Question: Summarize what this figure shows in one sentence.
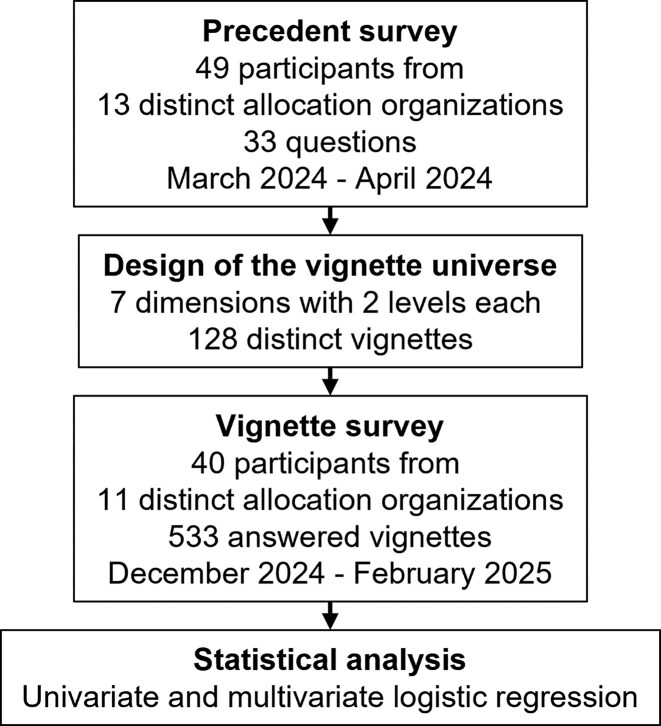
Answer: Process of survey conduction and vignette universe design. First, an initial precedent survey consisting of 33 questions about the decision-making process of a kidney offer to a pediatric kidney transplant recipient was conducted among 49 participants from 13 different distinct allocation organizations. Based on the results from the precedent survey, a vignette universe consisting of seven different dimensions with two different levels each resulting in 128 distinct vignette cases was designed in order to create a vignette survey. The vignette survey, which covered seven dimensions of a fictitious pediatric kidney offer [e.g. MMs on HLA loci, donor age, and donor kidney function (Table 1 )], was conducted, resulting in 533 completed cases. These cases could then be statistically analyzed using uni- and multivariate mixed-effects logistic regression models.